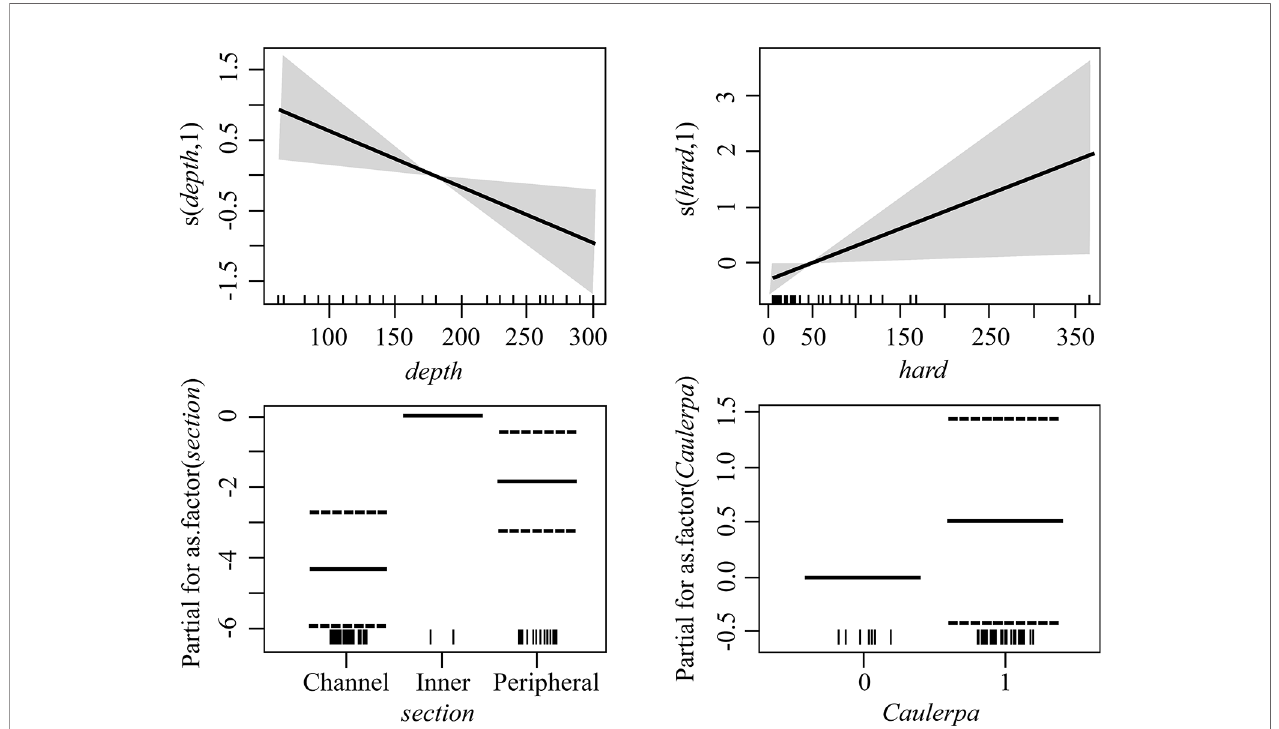
FIGURE 8 | Estimated terms in the best model for all alien and cryptogenic species abundance on the sea fl oor. The smooth terms or estimated levels of categorical predictors (unbroken black lines) are given in the linear predictor scale. The corresponding 95% con fi dence intervals are given as gray shadows/dotted lines. Rug plot on the horizontal axis represents density of data points.